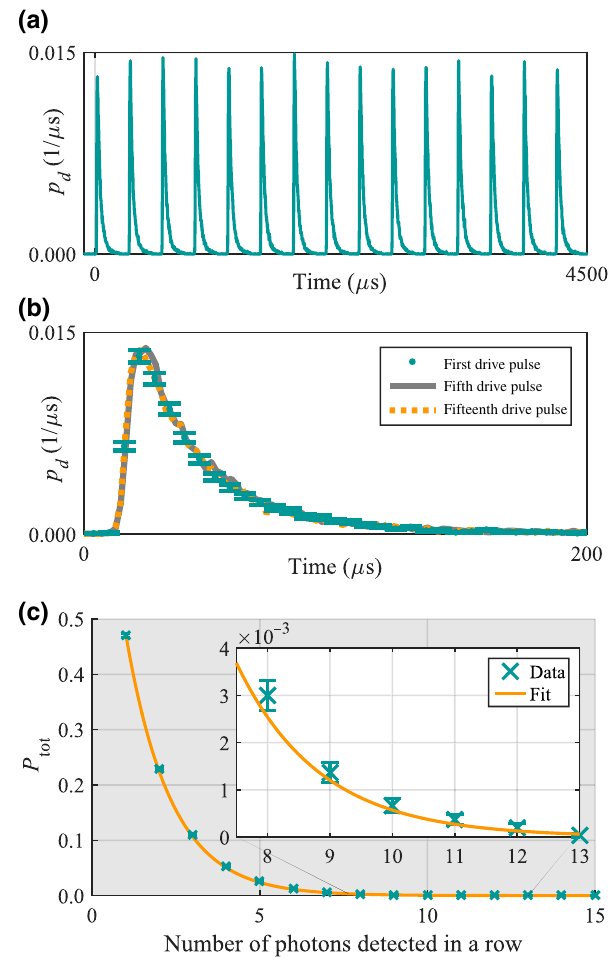
FIG. 5. Photon trains: generation and detection of sequential photons (a) Measured wavepackets of 15 consecutive photon- generation attempts for the experimental configuration of Fig. 2 and (cid:8)/ 2 π ≈ 12 MHz. (b) Temporal overlap of the first, fifth, and fifteenth wavepacket in (a). (c) Probability of detecting a photon in n consecutive wavepackets, starting from the first wavepacket, for a single-photon probability of 0.47. Orange line: weighted fit of the form p x , with p = 0.474 ( 2 ) the best fit